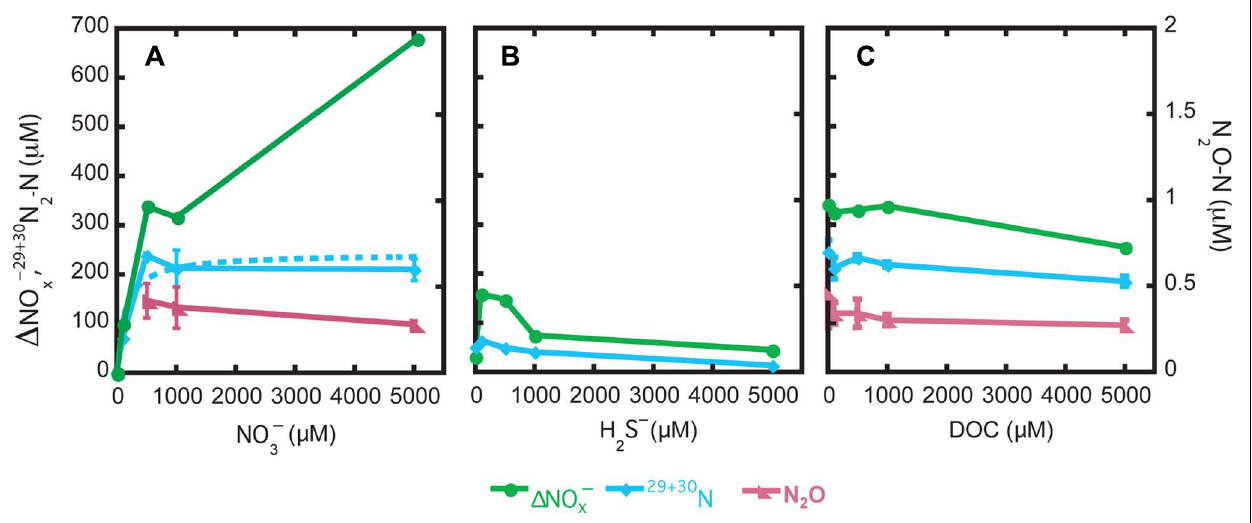
( ± 1.4) μ M N day − 1 , but this difference was not statistically sig-